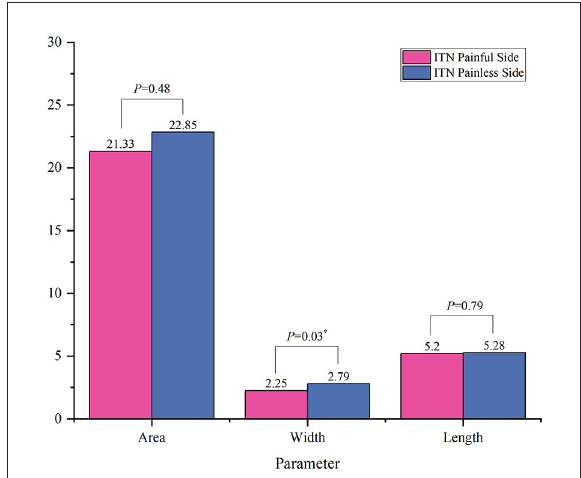
FIGURE3 Morphometric differences between the painful side and the painless side in the ITN group. * p < 0.05.